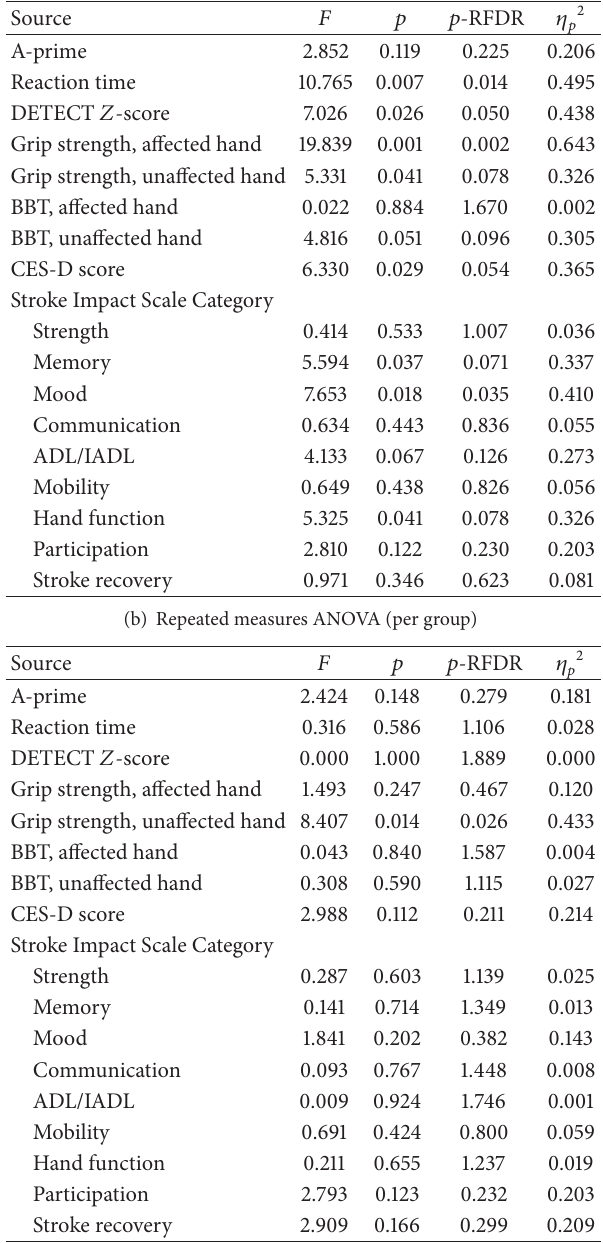
Table 2: ANOVA table for (a) time, (b) treatment group, and (c) time × treatment interaction for A-prime, reaction time, DETECT 𝑍 -score, grip strength, BBT, CES-D, and SIS categories. There was a significant main effect of time on reaction time, DETECT 𝑍 -score, grip strength of the affected hand, and CES-D score. There was a significant main effect of treatment group on grip strength of the unaffectedhandonly.Therewasasignificanttime × treatmentgroup interaction for SIS overall stroke recovery rating